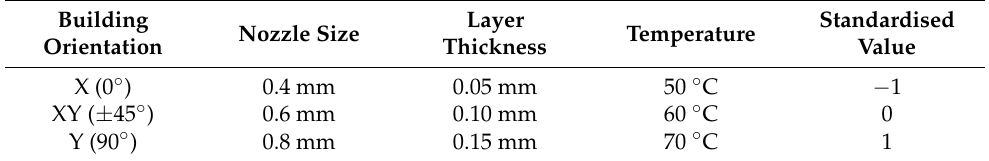
Table 3. Standardized Value for different parameters.